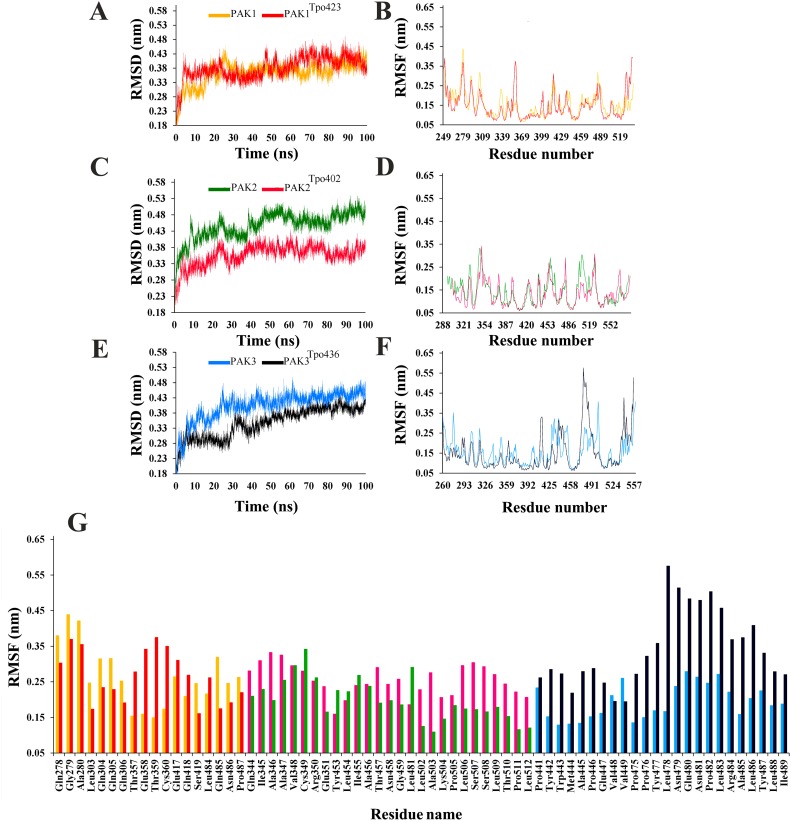
MD simulation analysis of group-I PAKs.(A and B) RMSD and RMSF plots for PAK1 (golden) and PAK1Tpo423 (red), (C and D) RMSD and RMSF plots for PAK2 (dark green) and PAK2Tpo402 (purple) and (E and F) RMSD and RMSF plots for PAK3 (sky blue) and PAK3Tpo436 (dark blue), respectively. (G) RMSF values of highly fluctuating residues are plotted and indicated by the corresponding colors.